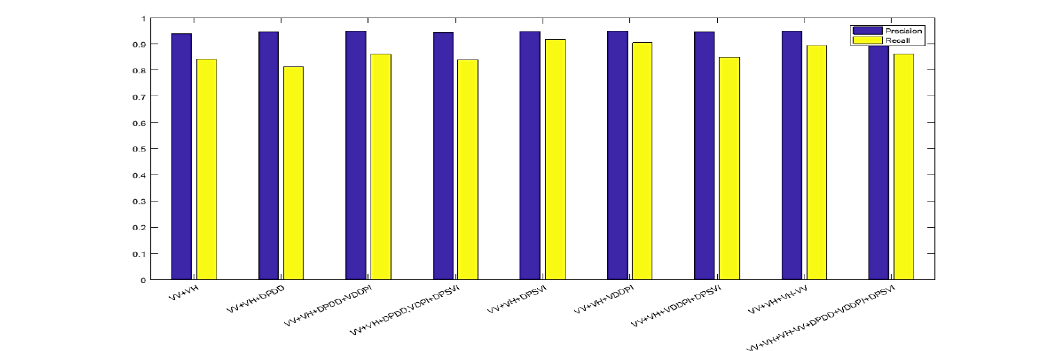
Figure 4: Precision and recall values of different combination of